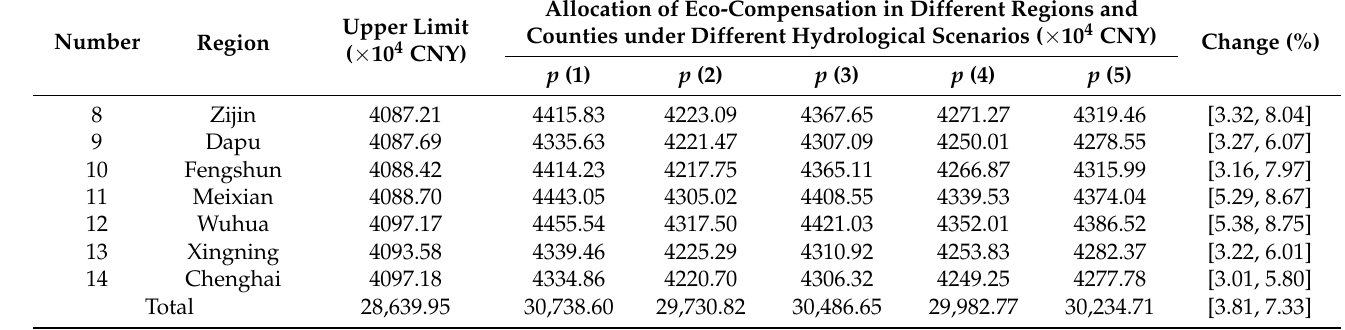
Table 6. Eco-compensation allocation of the downstream administrative units under different hydro- logical scenarios based on the IFTS model (upper